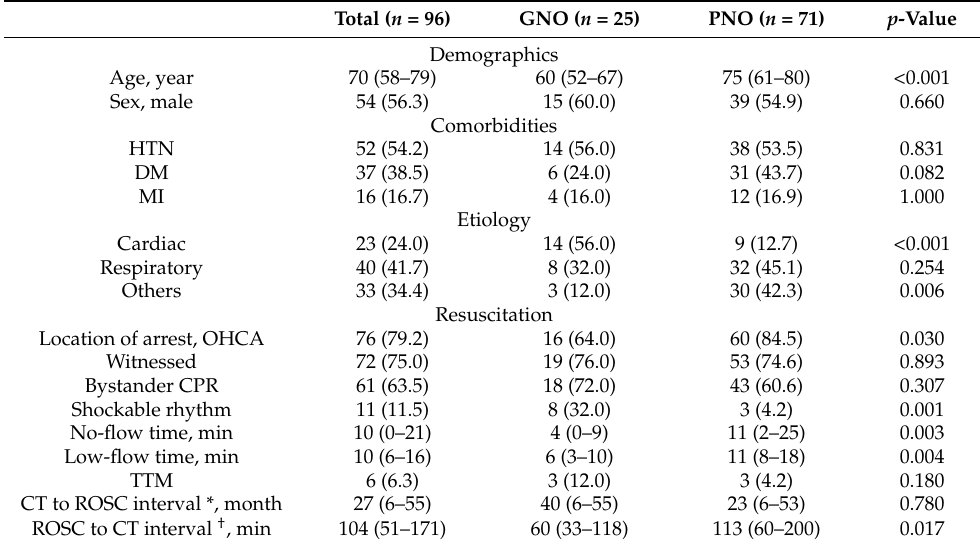
Table 1. Baseline characteristics of enrolled